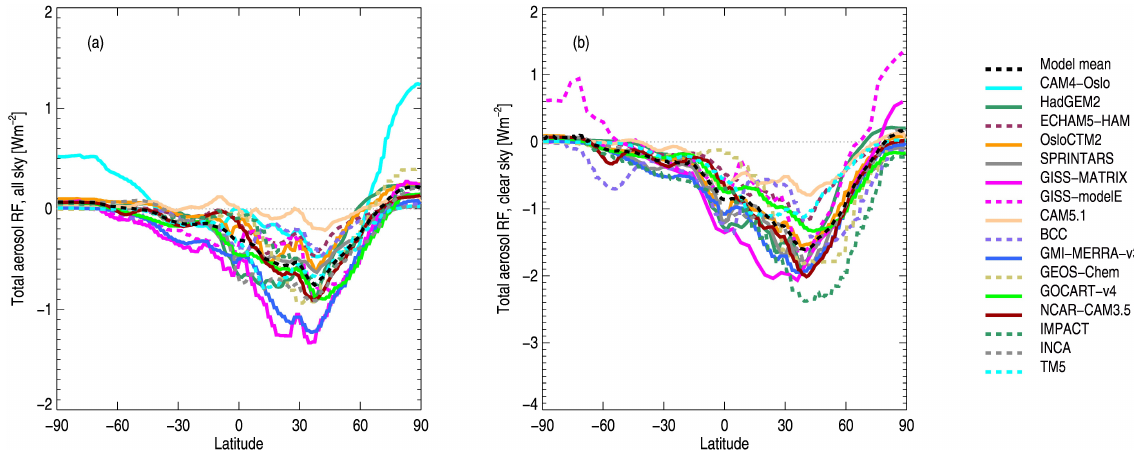
Fig. 2. Zonal mean DAE RF for all-sky (a) and RF for clear sky (b) .